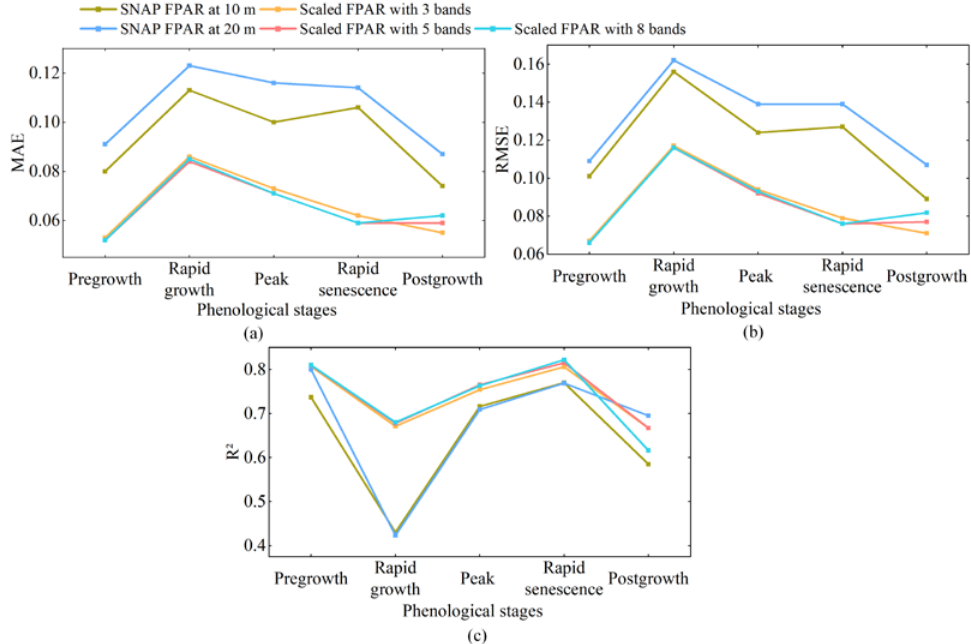
Figure 9. The agreement of the Sentinel FPAR images estimated by the SNAP and the scaling-based method during different phenological periods. ( a ) MAE. ( b ) RMSE. ( c ) R². Phenological stages are (1) pre-growth from DOY 1 to DOY 100, (2) rapid growth from DOY 101 to DOY 130, (3) peak stage from DOY 131 to DOY 260, (4) rapid senescence from DOY 261 to DOY 320, and (5) post-growth from DOY 321 to DOY 365.